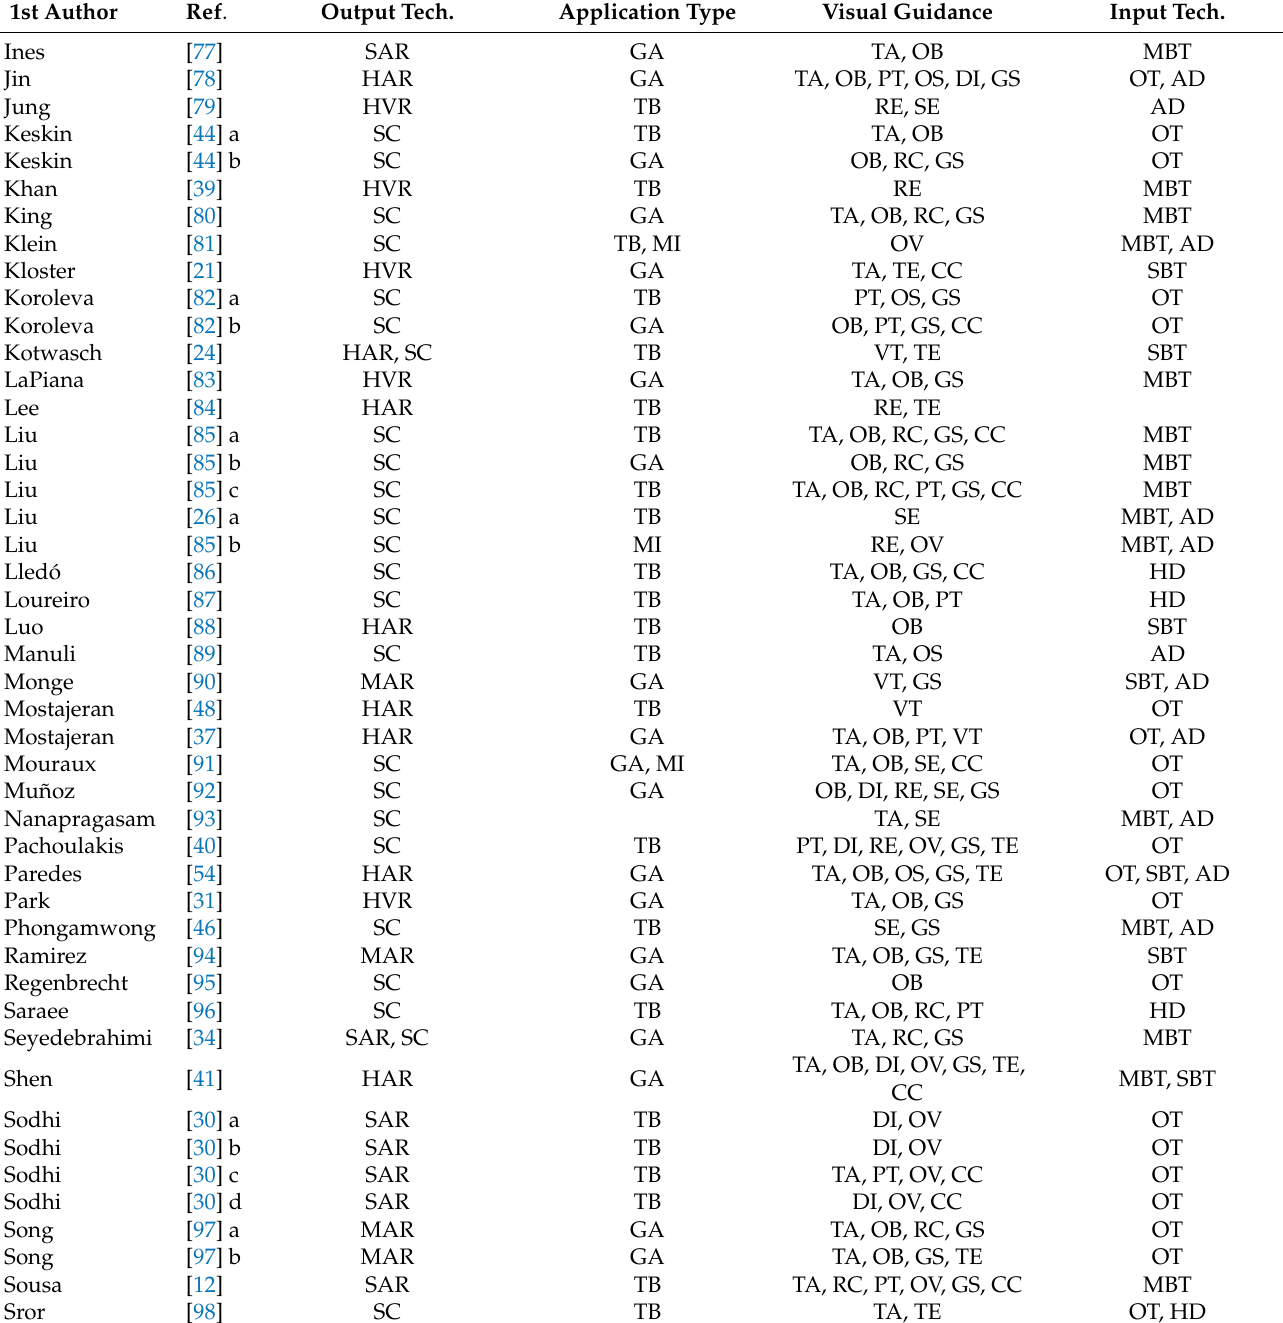
Table A4. Overview of the selected references—author names I–Sr, part 2/2, Abbr. in Table A7. Distinct applications within a reference are marked with lowercase